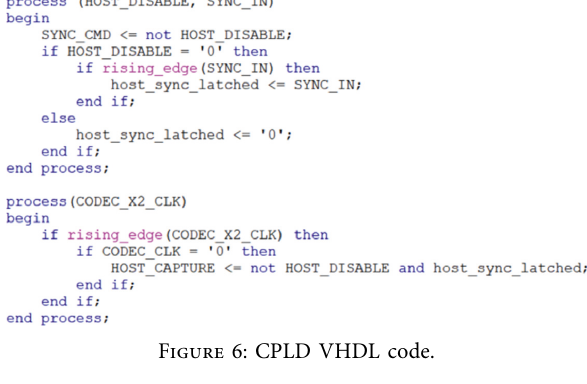
Figure 6: CPLD VHDL code.